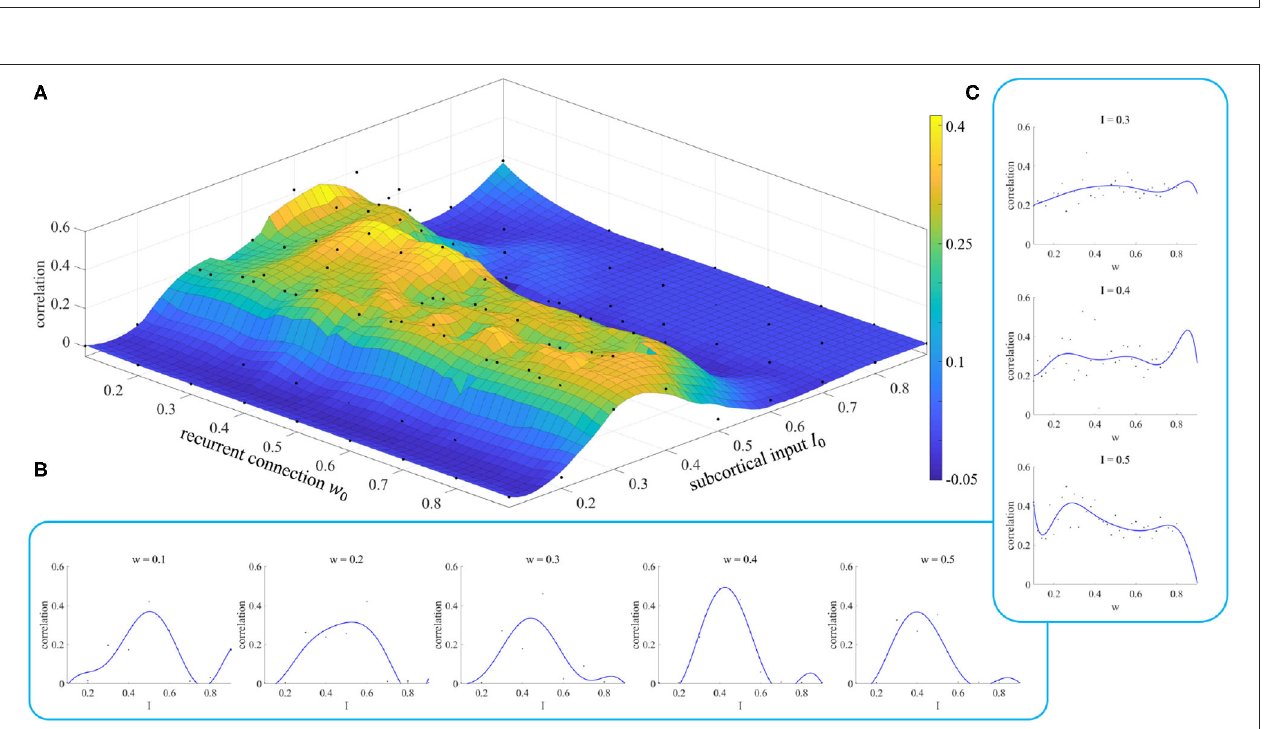
FIGURE 7 | Simulation results of parameter initialization. (A) Each point represents the correlation result corresponding to a pair of parameters ( w , I ). (B) Variation of the correlation with the parameter I for given values of the parameter w . (C) Variation of the correlation with the parameter w for given values of the parameter I .